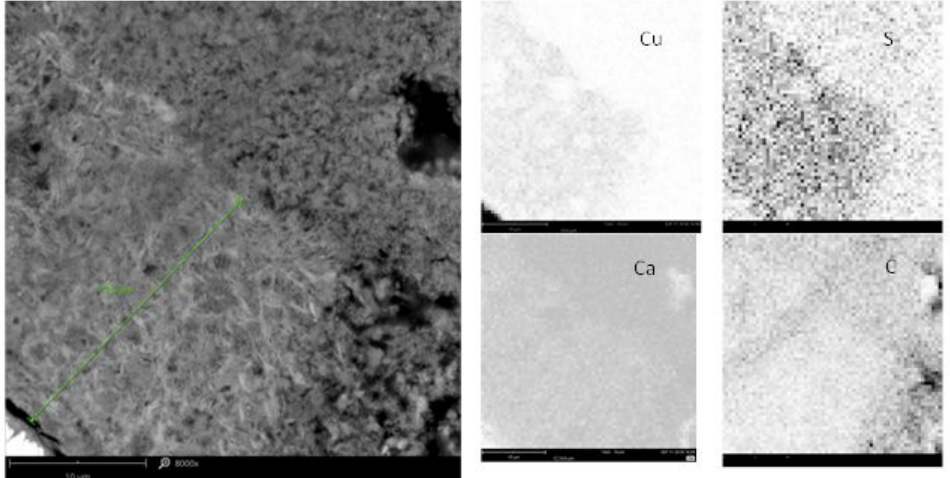
Figure 5. Elementary mapping performed on the copper – lime